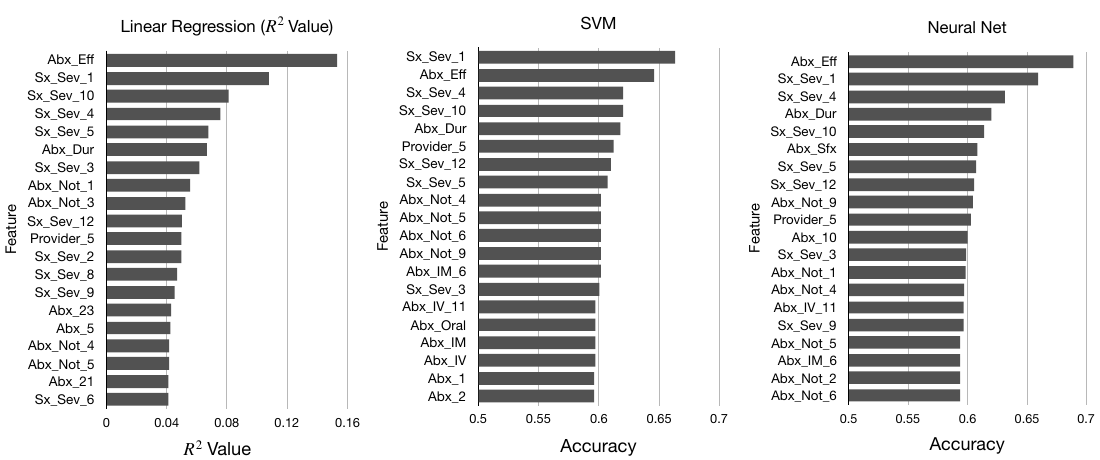
Figure 2. ( Left ) R 2 values of individual features, ( middle ) SVM accuracy of individual features, ( right ) neural net accuracy on individual features, on MLD.